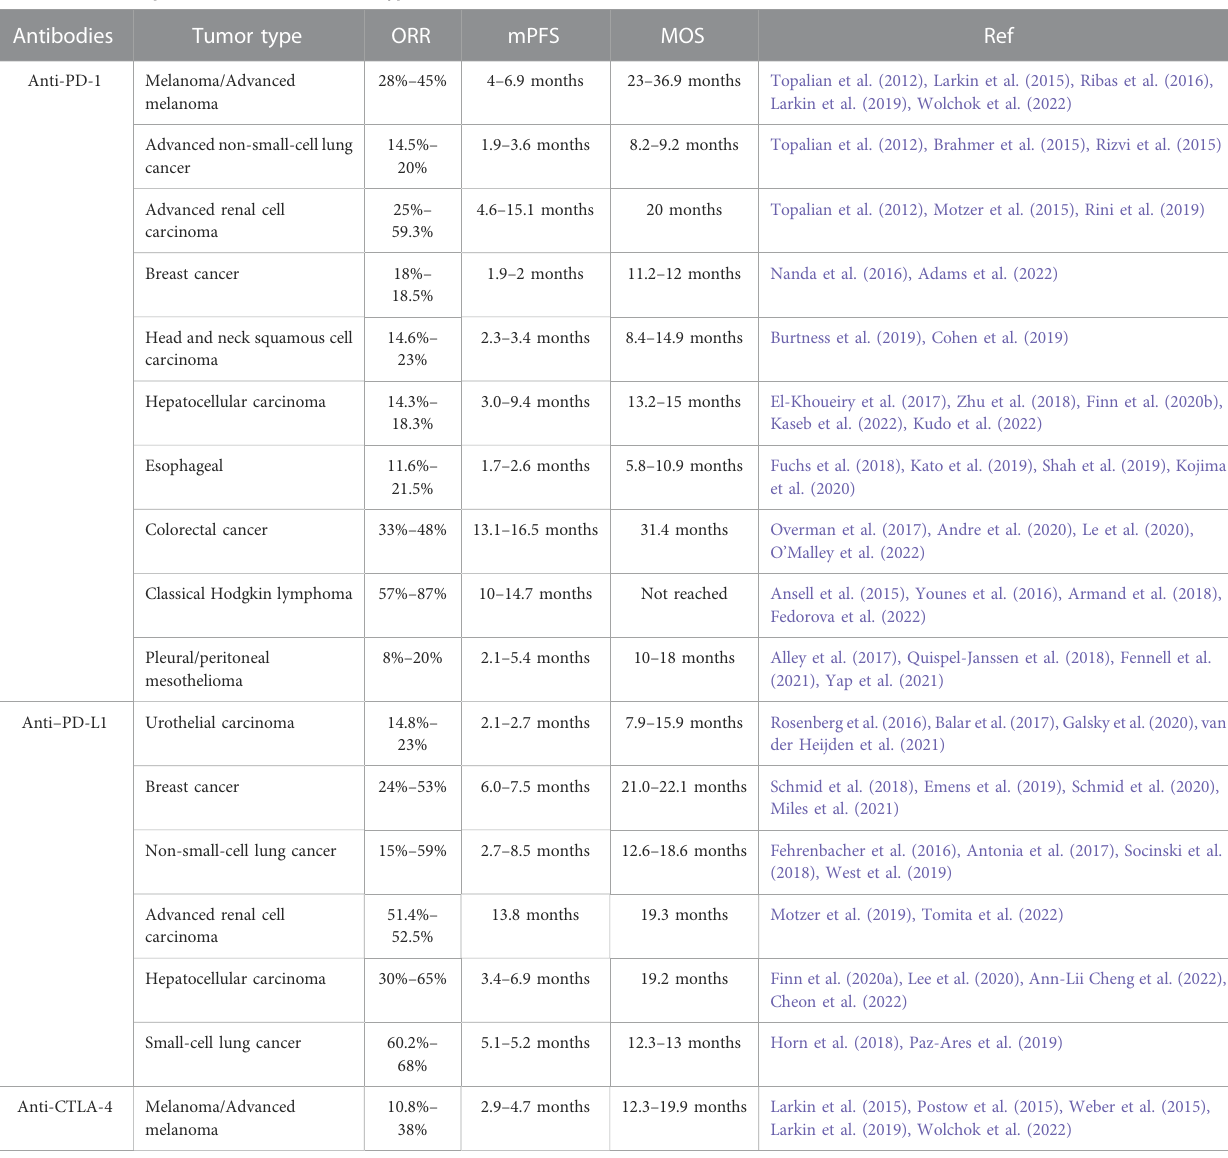
TABLE 1 Clinical response rate of various tumor types to